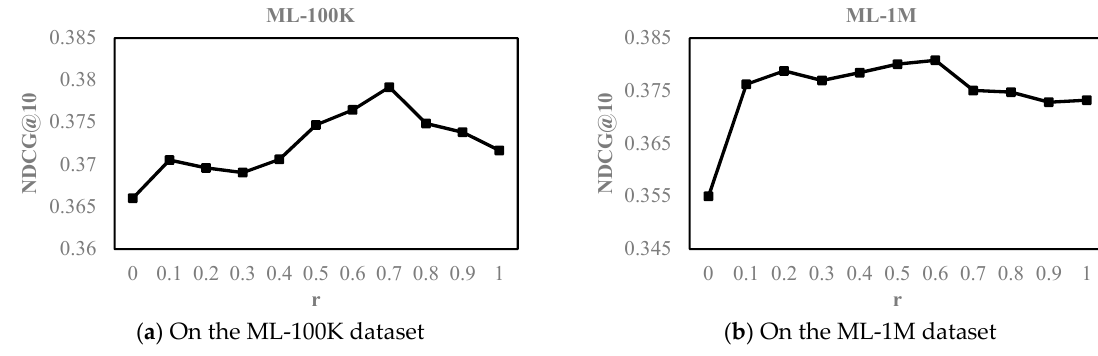
( b ) On the ML-1M dataset Figure 5. Performance of r based on Figure 5. Performance of 𝑟 based on NDCG@10.